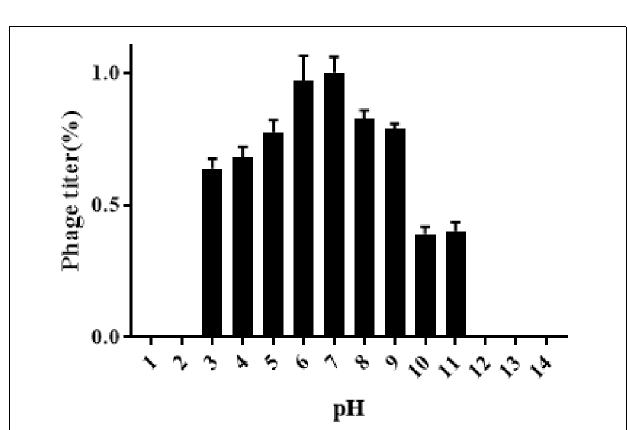
FIGURE 4 | pH stability of phage vB_EaeM_ ϕ Eap-3. Each data point represents the mean of three independent experiments. Standard deviations are shown as vertical lines. Results are expressed as PFU/mL.